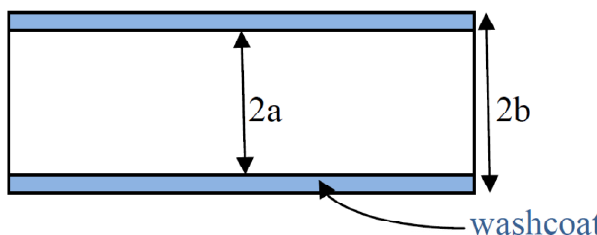
(cid:3019) Ω (cid:3118) (cid:3019)